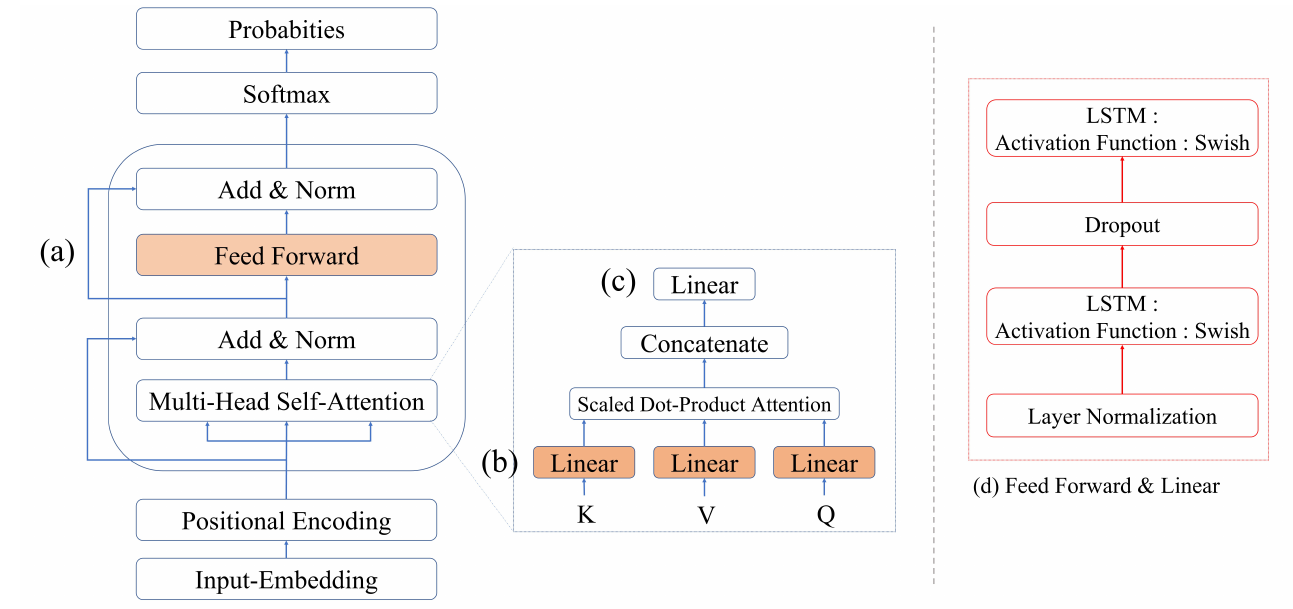
Figure 4. The architecture of the Sl